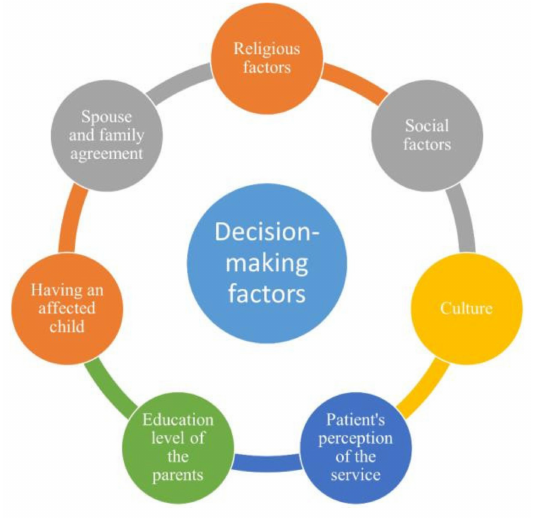
Figure 1. The different factors affecting decision making in prenatal genetic clinics among Arab